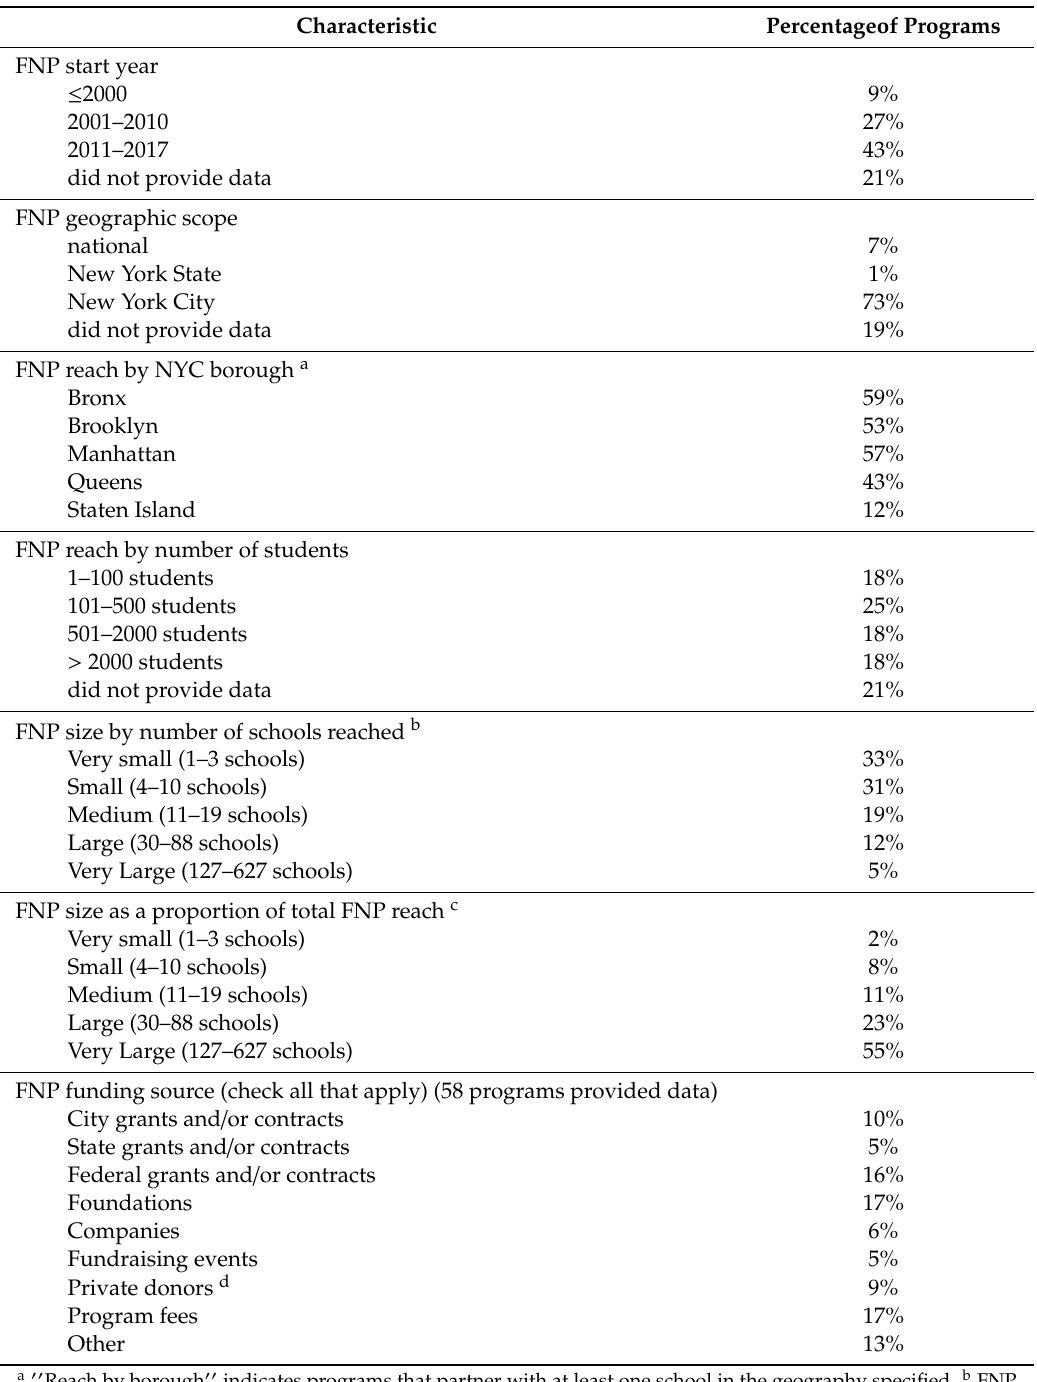
Table 2. Administrative and Funding Characteristics of Food and Nutrition Education Programs (FNPs) ( n = 101